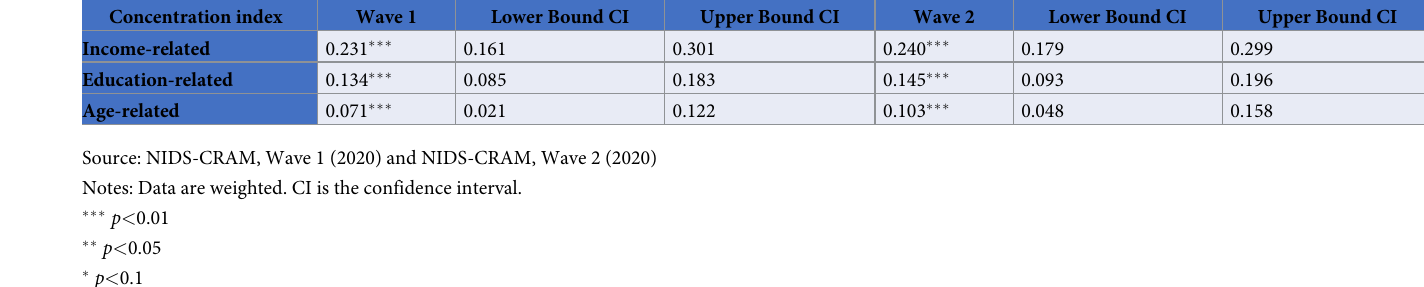
Table 5. Erreygers’-corrected concentration index of risk